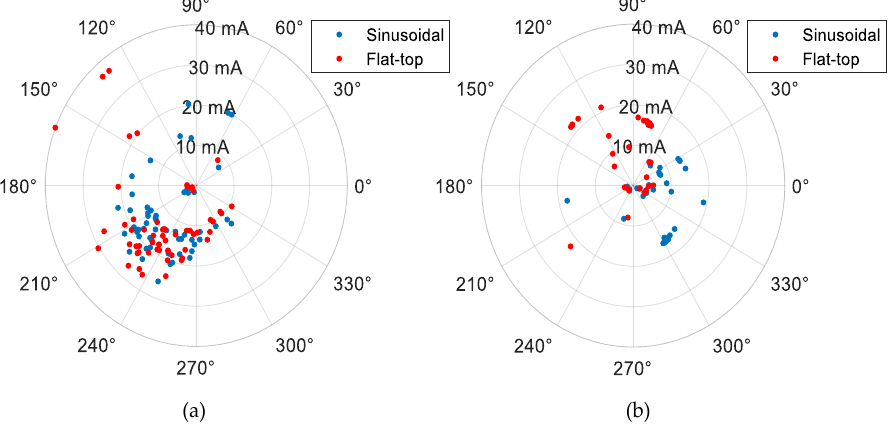
Figure A6. Eleventh harmonic current emission of the selected lamps under the two types of supply voltage: ( a ) CFL and ( b ) LED lamps.